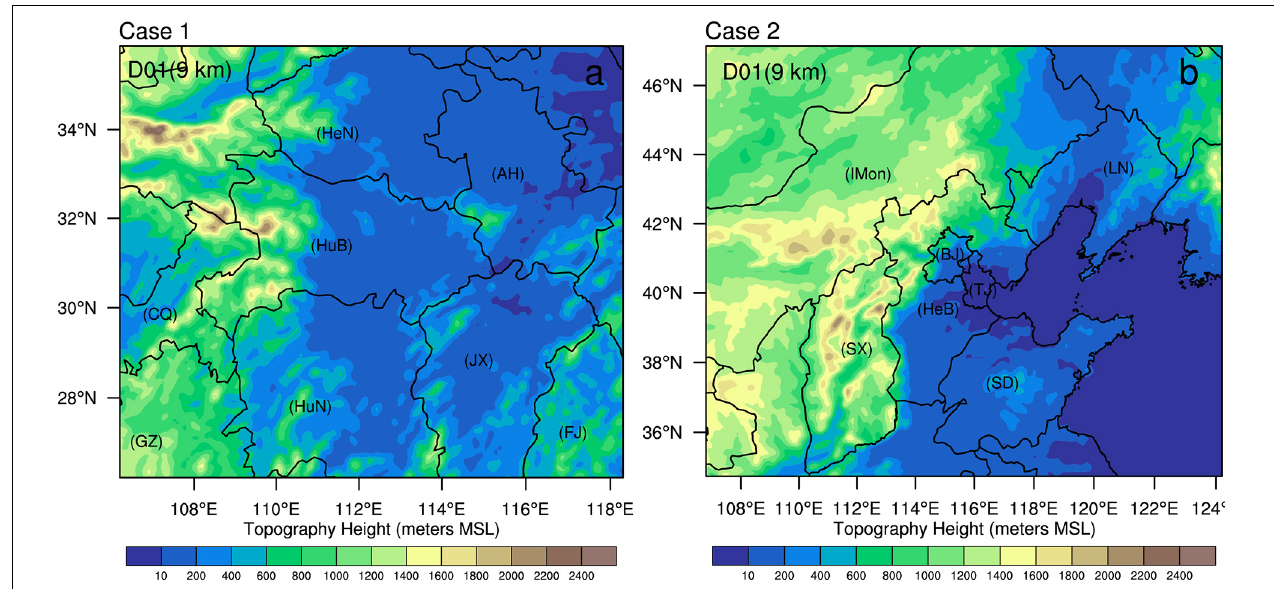
FIGURE 1 | Configuration of the WRF model domain for two cases. (a) Case 1 for 30 June 2018. The abbreviations for Henan, Anhui, Hubei, Chongqing, Guizhou, Hunan, Jiangxi, and Fujian Provinces are HeN, AH, HuB, CQ, GZ, HuN, JX, and FJ, respectively. (b) Case 2 for 12 June 2018. The abbreviations for Inner